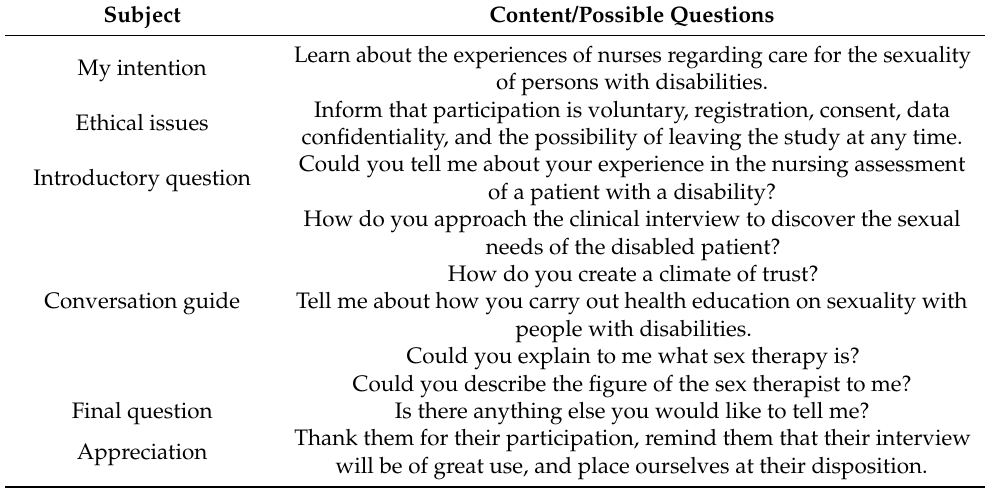
Table 2. Interview protocol.